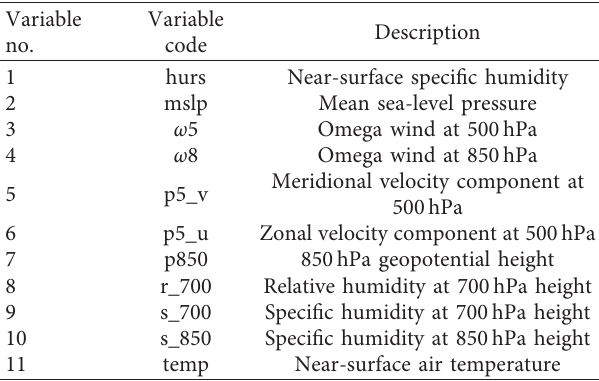
Figure 2: Schematic illustration of the hydrological impact study framework (note: the methods are shown in italics). Table 4: NCEP and GCM daily predictor variables, codes, and